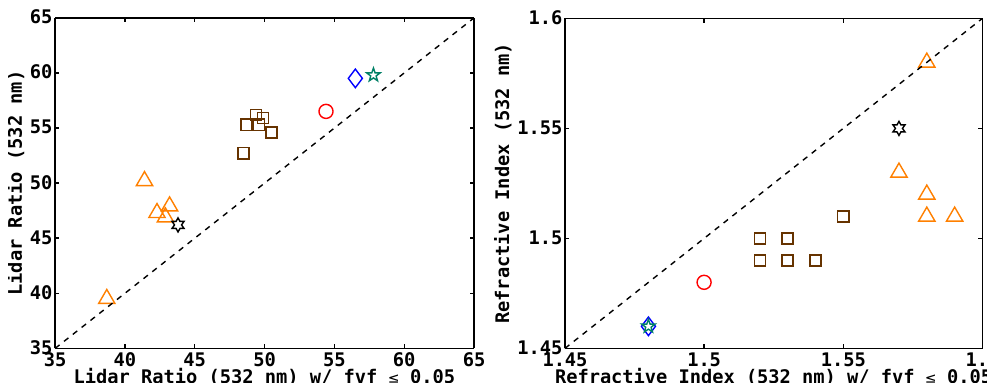
Fig. 10. Left panel: Comparison of the median lidar ratios for dust (i.e., depolarizations greater than 0.2) to the median lidar ratios for “pure” dust (fvf ≤ 0.05 and depolarization ratio greater than 0.2). Right panel: Comparison of the median real refractive index for dust to the median real refractive index for “pure” dust. Note that the median lidar ratio increases when the fine mode is included, and the median real refractive index decreases when the fine mode is included. Symbol shapes correspond to the shapes in Fig. 8.